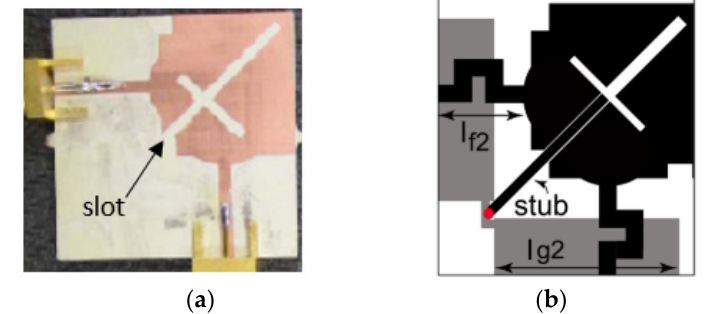
Figure 9. ( a ) Slots etched in the common radiator antenna design [67], ( b ) Open shunt stub placement and etched T-shaped slots in the common radiator antenna design [68].